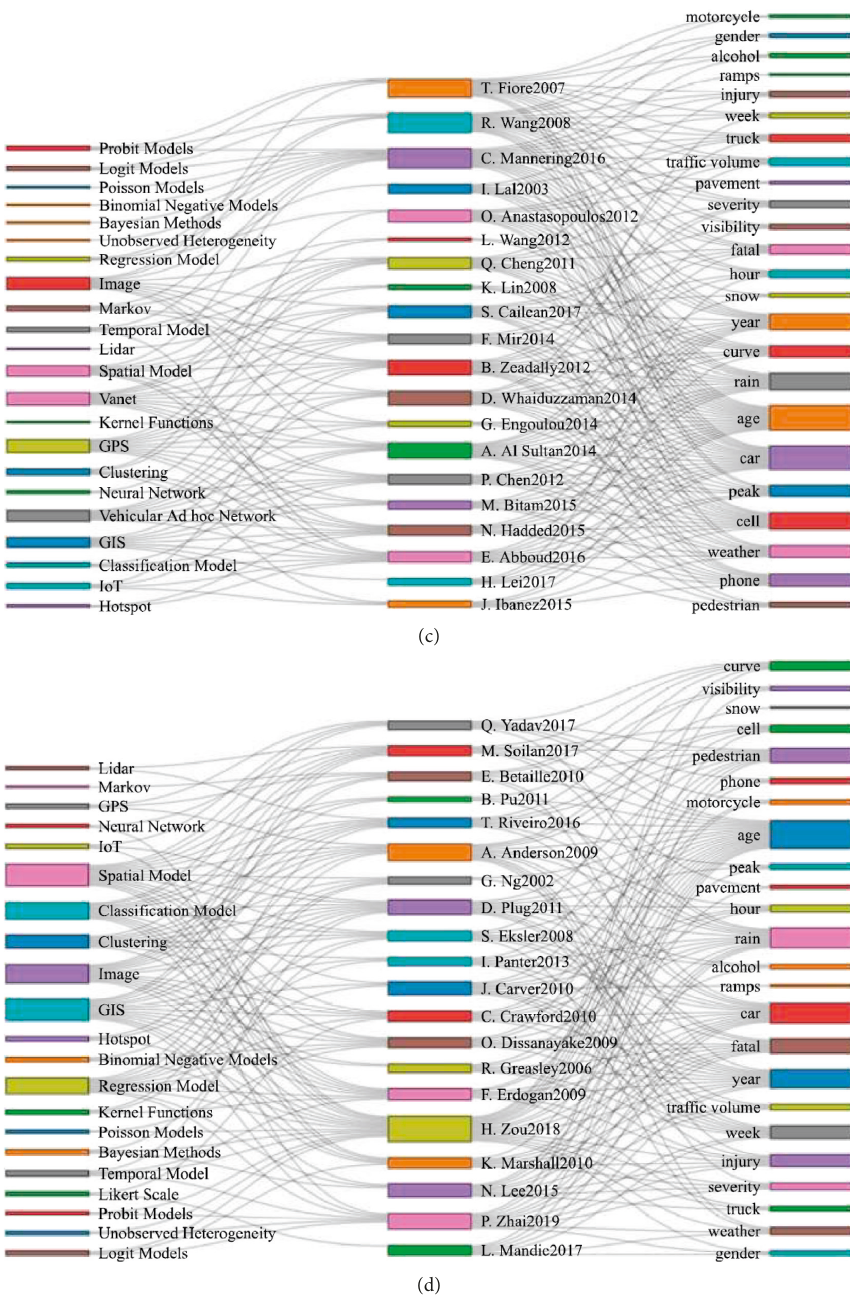
Figure 6: Graph Sankey–Ferreira, relationship between papers, methods, and variables (a) RTA+HA +SM, (b) RTA+HA +ML, (c) RTA+HA +SC, and (d) RTA+HA +GIS